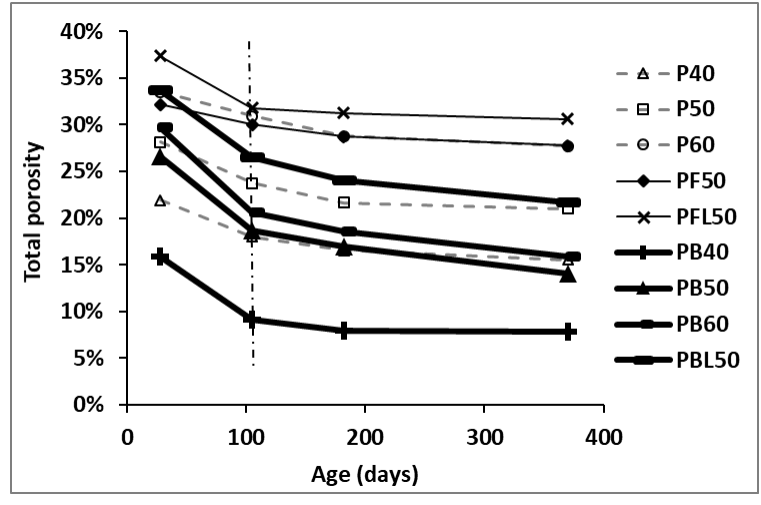
Figure 8. Evolution of total porosity with age in various cementitious pastes.